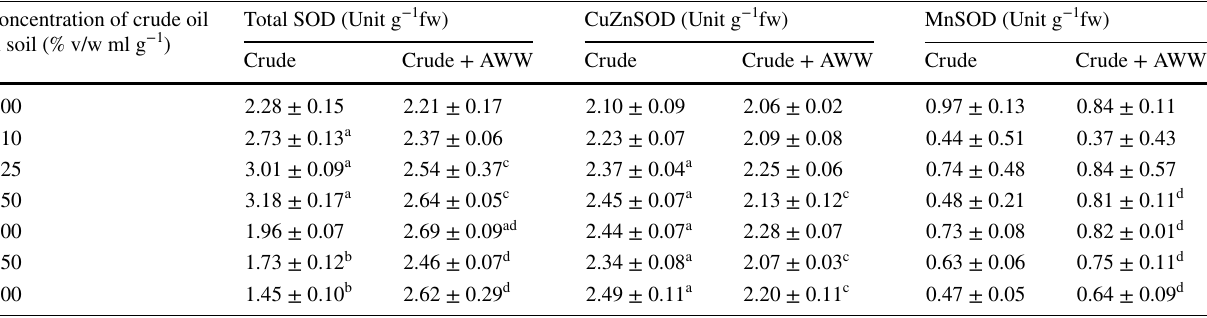
Results are expressed as mean ± SD of three determinations a Significantly higher than control b Significantly lower than crude oil alone treatment c Significantly lower than the control d Significantly higher than crude oil alone Table 5 Effect of abattoir wastewater on superoxide dismutase activities cowpea seedlings planted in crude oil treated soil